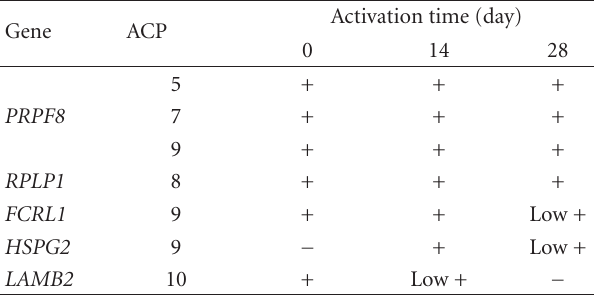
Table 1: Activation pattern of specific genes in response to orthodontic treatment at various